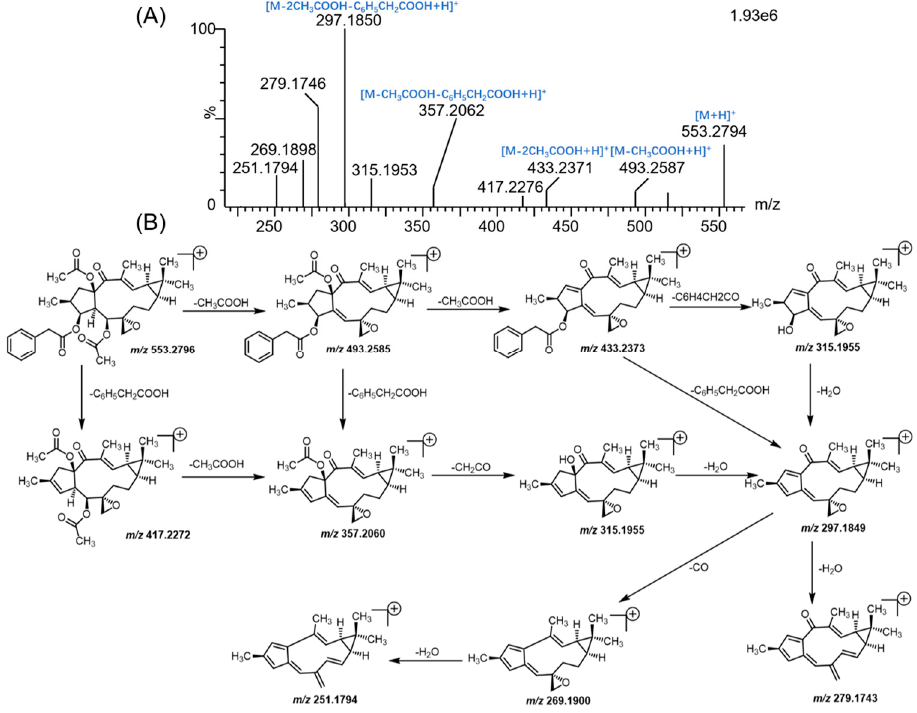
Figure 2. The mass spectrum ( A ) and proposed MS/MS fragmentation patterns ( B ) of euphorbias- teroid.